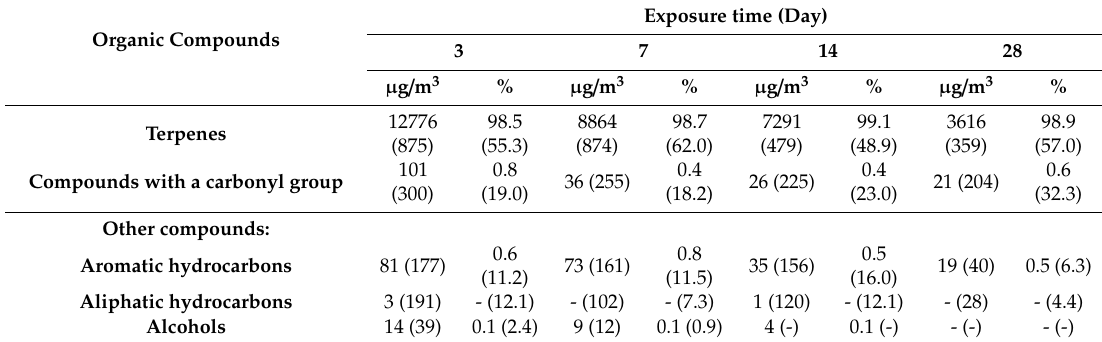
Table 3. Concentration of volatile organic compounds emitted from heartwood and sapwood part of Scots pine wood ( Pinus sylvestris L.) after 3, 7, 14, 21 and 28 days of exposure of samples (values in brackets represent sapwood).